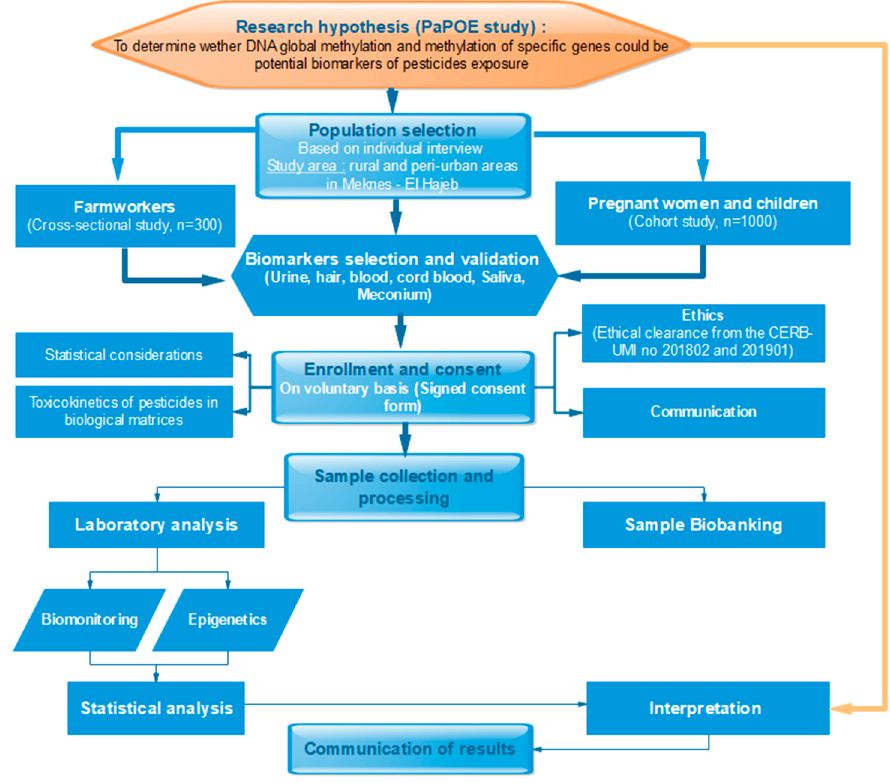
Figure 2. Flowchart of the PaPOE study.